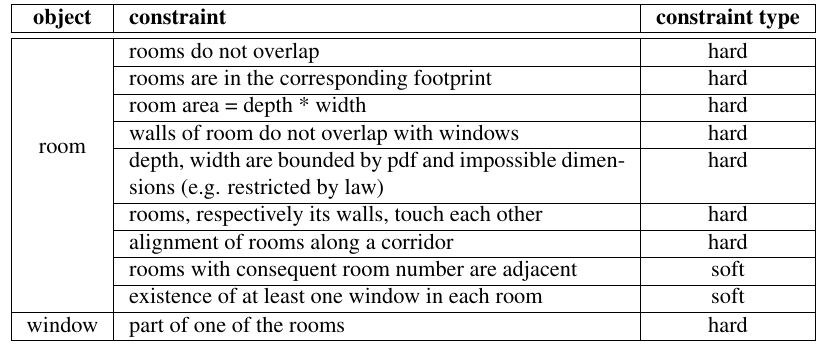
Table 1: constraints for modelling floorplans. Soft constraints do not have to be satisfied but only a limited number of non satisfied constraints is allowed